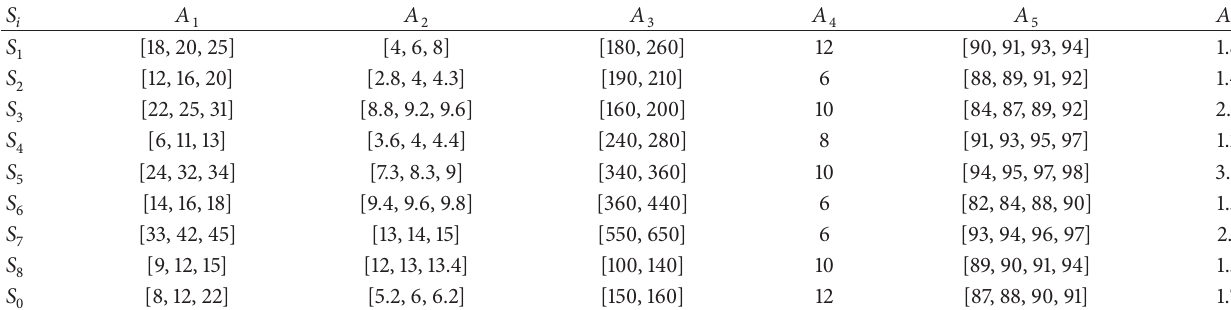
Table 1: Safety data from coal mines.